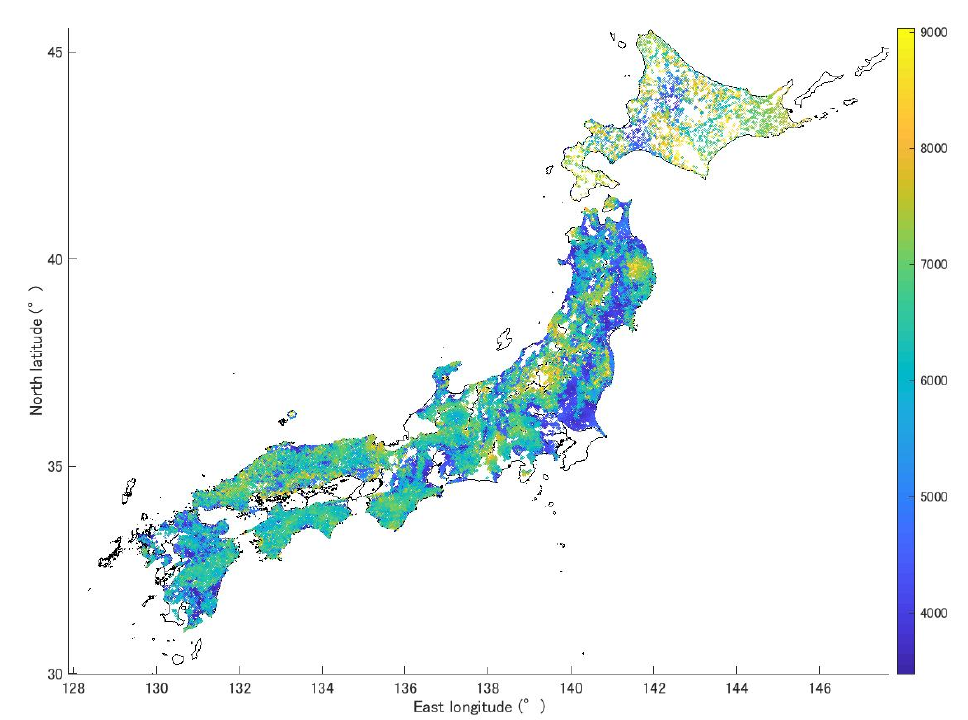
Figure 1. Harvesting costs (JPY/m 3 ).